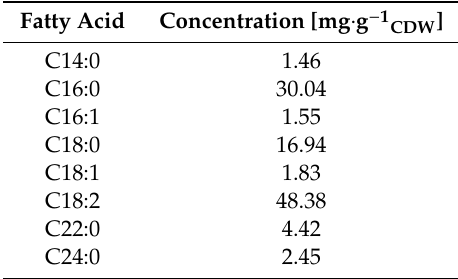
Table A1. Analysis of fatty acids in intracellular lipid droplets in U. rabenhorstiana of a fed-batch cultivation in 1 L-bioreactor (Section